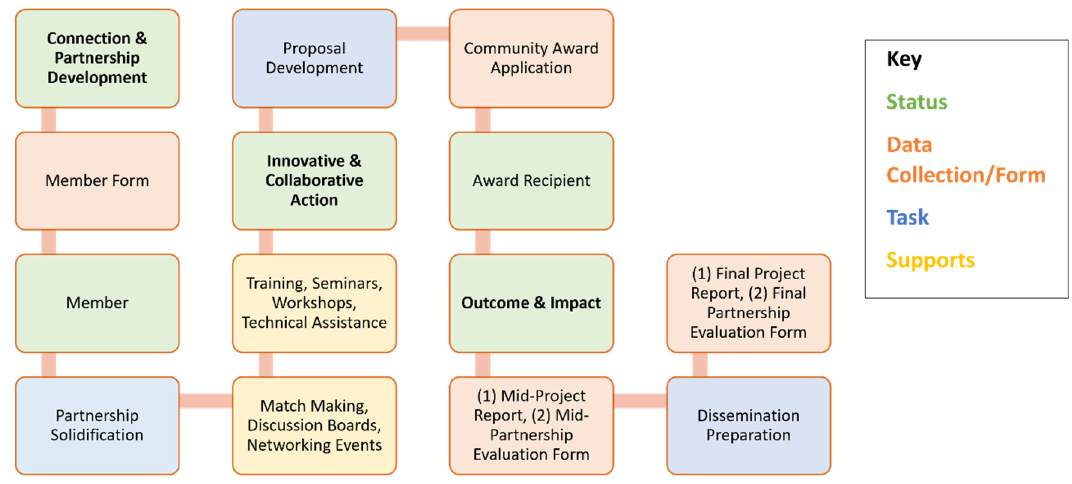
Figure 2. Morgan CARES Community Award